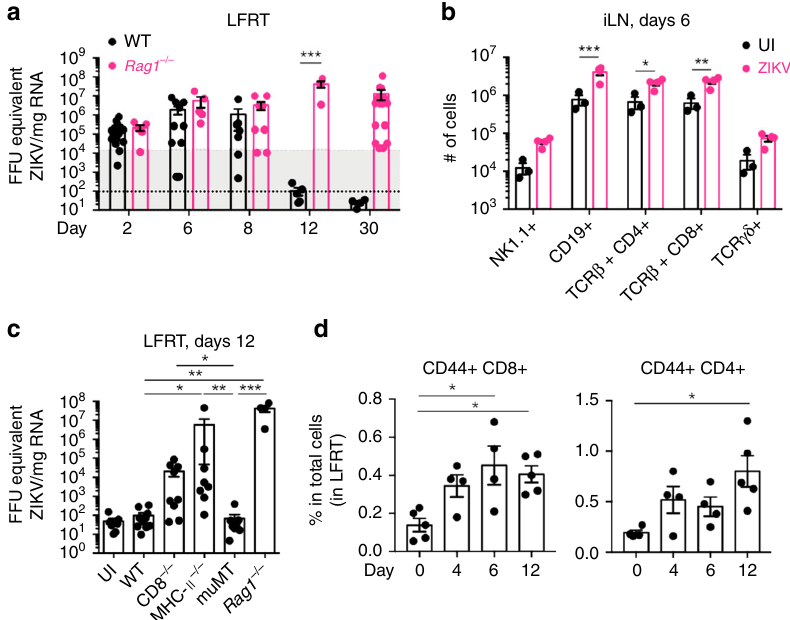
Fig. 1 Adaptive immunity is required for resolution of vaginal ZIKV infection. Groups of DMPA-treated female mice were i.vag. inoculated with 2 × 10 4 FFU of ZIKV (PRVABC59). a FFU equivalents of ZIKV in total RNA from LFRT tissues were determined by qRT-PCR. ZIKV RNA level at day 1 post infection has been indicated by the shaded area, and the lower limit of viral detection is indicated by the lower black dotted line. WT day 2 n = 16, day 6 n = 11, day 8 n = 7, day 12 n = 5, day 30 n = 5; Rag1 − / − day 2 and 6 n = 5, day 8 n = 8, day 12 n = 4, and day 30 n = 17 mice. b Absolute numbers of indicated immune cells in the iLN of uninfected (UI, n = 3 mice) and ZIKV-infected animals ( n = 4 mice) at day 6 p.i. c FFU equivalents of ZIKV in LFRT at day 12 post infection. UI n = 7, WT n = 11, CD8 − / − n = 9, MHC-II − / − n = 8, muMT n = 9, Rag1 − / − n = 4 mice. d Frequencies of CD44 + T cells in the LFRT were determined using fl ow cytometry. Day 0 represents UI mice. Day 0 and 12 n = 5 mice each day, day 4 and 6 n = 4 mice each day. See Supplementary Fig. 1 for gating strategy. Data pulled from 4 a , or 2 b, c independent experiments; mean ± SEM. * p < 0.05; ** p < 0.01; *** p < 0.001; two-way ANOVA with Bonferroni ’